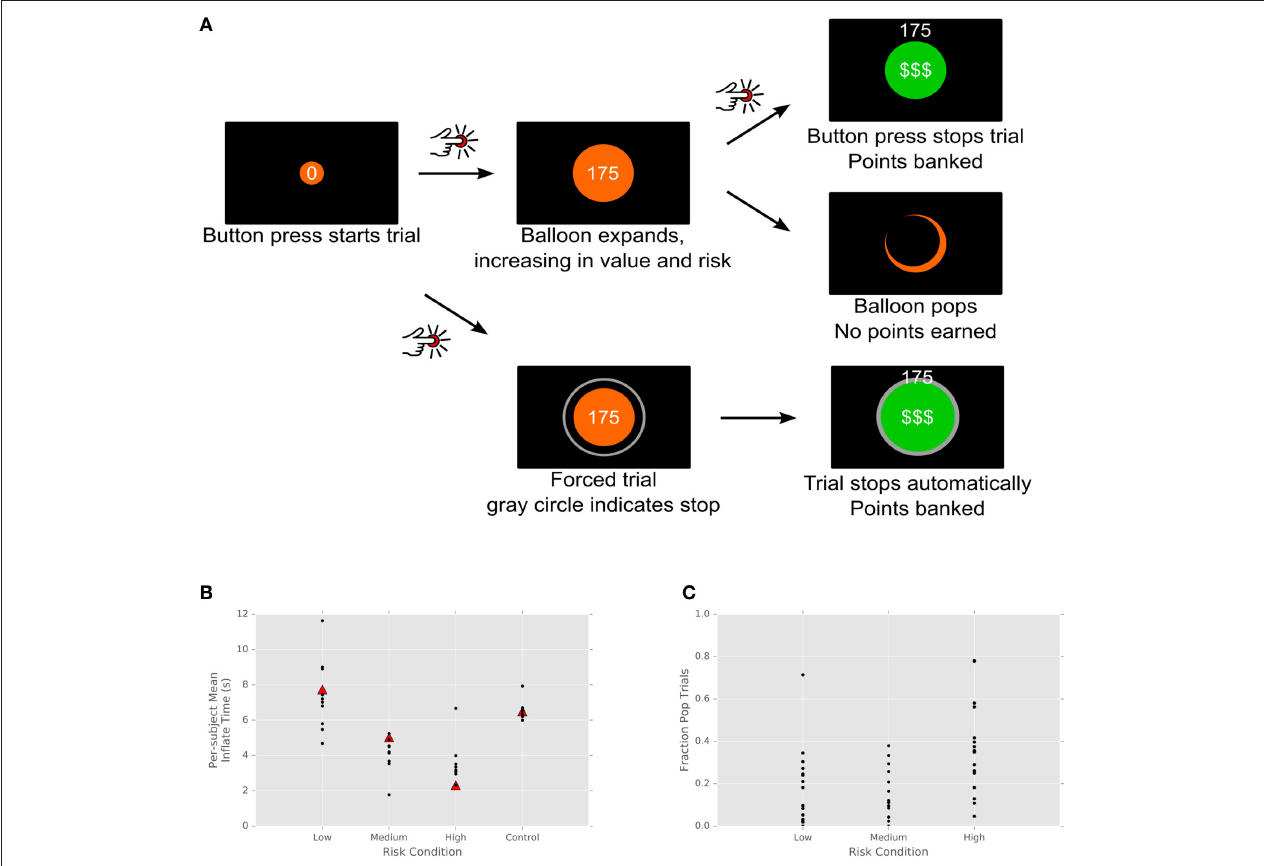
FIGURE 1 | Task design and performance. (A) Participants pressed a button to begin inflating a virtual balloon onscreen. The value of the balloon grew with its size. Participants either clicked the joystick a second time, banking the balloon’s value, or the balloon popped, earning no points. Balloons came in three colors, indicating different distributions of pop times and thus differing levels of risk. (B) Subject performance by risk condition. Each subject’s mean inflate time is plotted for each risk condition and for control trials. Triangles indicate the mean of the actual pop time distribution, unknown to subjects. Control trials, in which the computer stopped the trial, show a tight cluster around the mean. (C) Fraction of pop trials for each subject. Each subject’s fraction of popped balloons is plotted for each trial